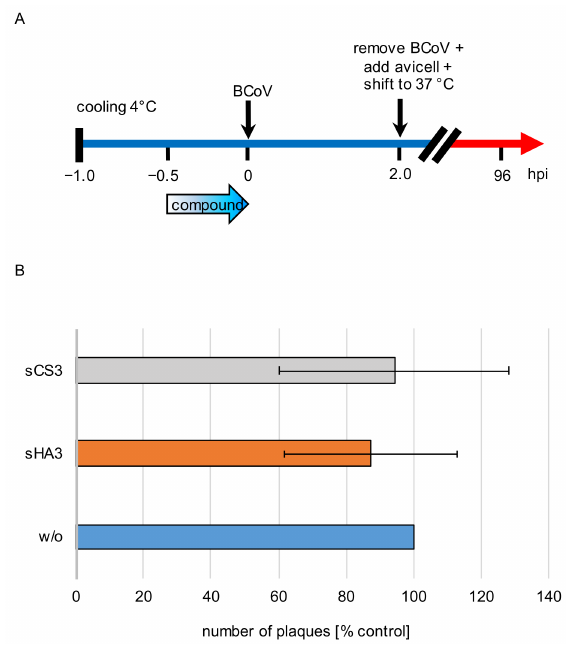
Figure 5. Effects of the high-sulfated GAGs on attachment. ( A ) Diagram of the experimental settings. ( B ) Prechilled PT cells were treated with 0.2996 µ M sHA3 or 1.7156 µ M sCS3 or left untreated ( w / o ) for 30 min at 4 ◦ C. After removing the inhibitors, cells were infected with prechilled BCoV (MOI